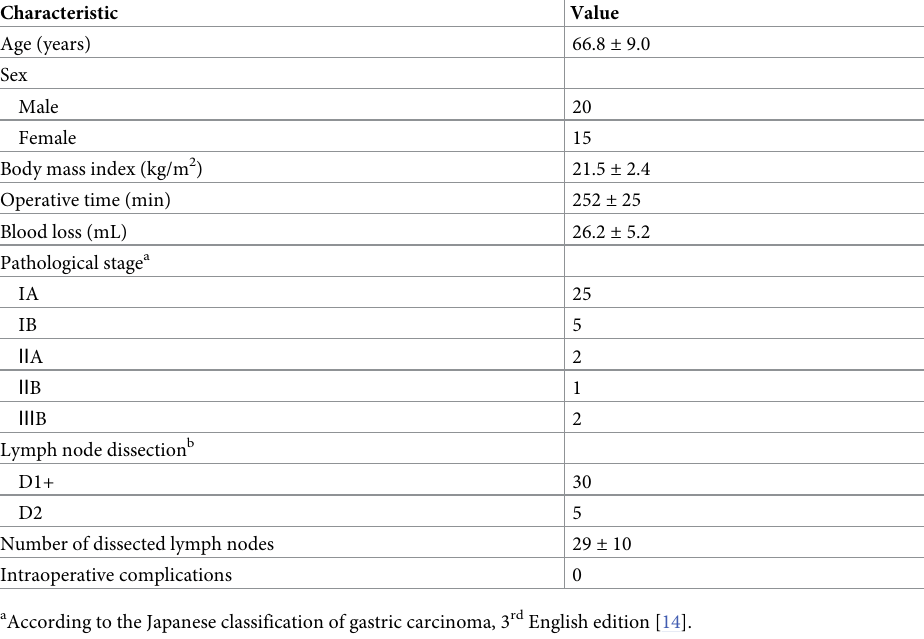
a According to the Japanese classification of gastric carcinoma, 3 rd English edition [14]. b According to the Japanese gastric cancer treatment guidelines 2014 (ver. 4) [19].